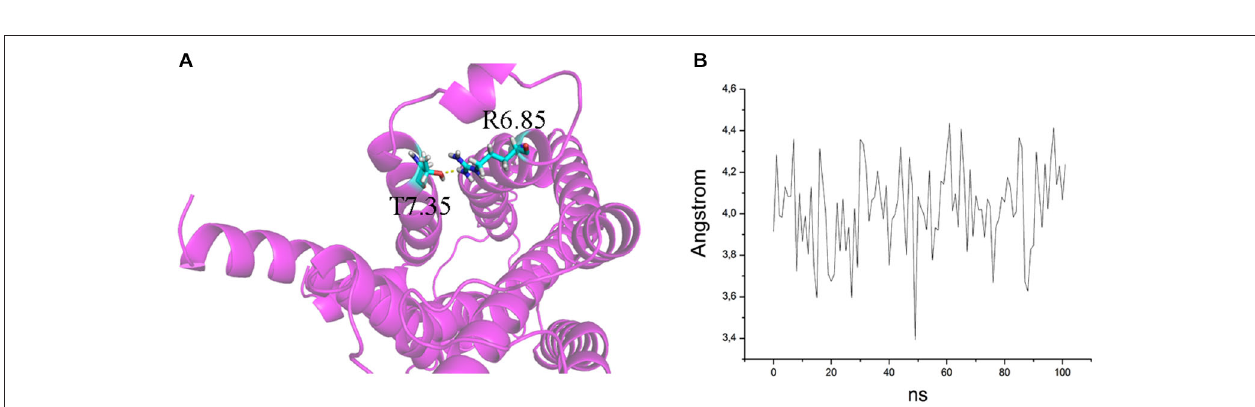
FIGURE 5 | (A) Overlap of R7.35 and R6.58 in the mutant E7.35R. The backbone is shown in cartoon representation and the residues are indicated in stick format. (B) Distance between the two guanidine groups of R7.35 and R6.58 measured over the MD trajectory.